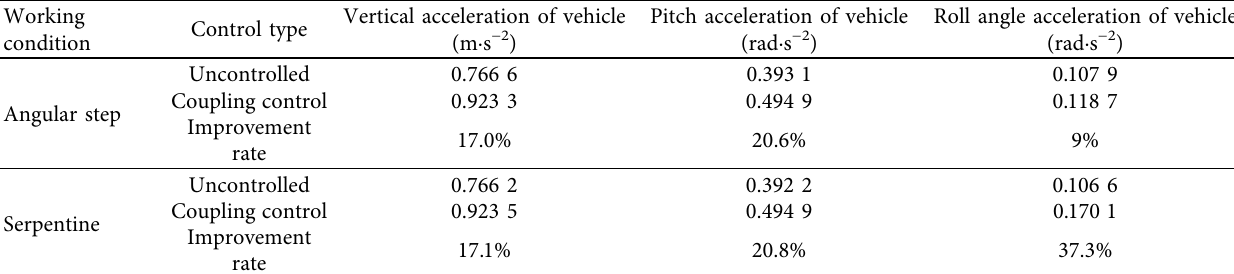
Table 3: Comparison of ride comfort control (B-level